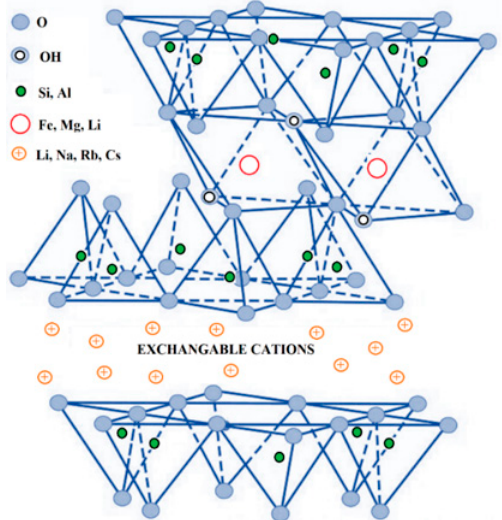
Figure 12. Example of the typical structure of the 2:1 layered silicates. Redrawn from [212] with permission of Elsevier. Copyright © 2015.